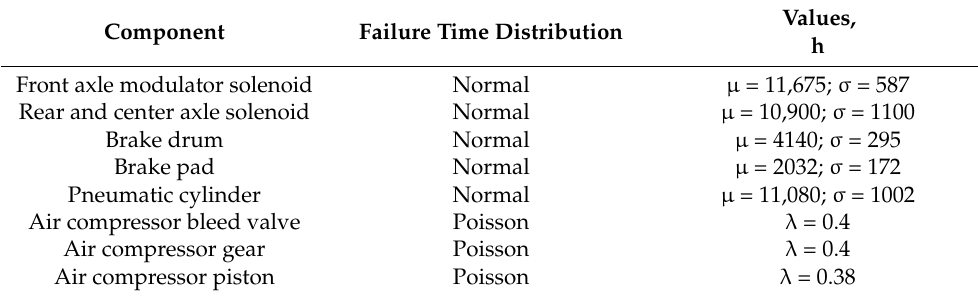
Figure 9. TASK AV module with five phases of operations for autonomous agrotechnical vehicles. Table 6. Brake system.